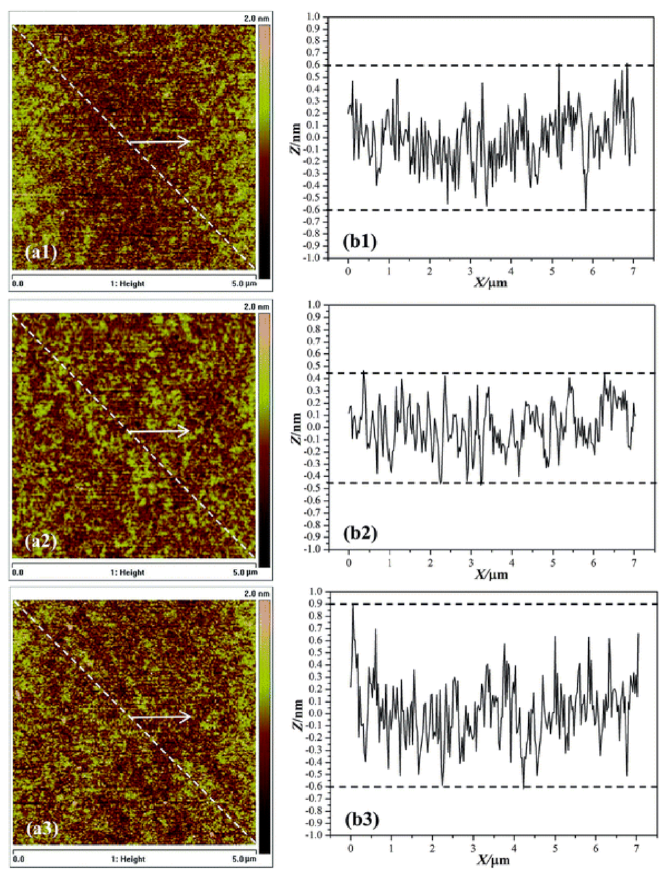
Figure 15. Two–dimensional AFM images and corresponding line scan profiles of the substrates after finishing with composites—A ( a1 , b1 ), —B ( a2 , b2 ), and —C ( a3 , b3 ), in which the line scan profiles in ( b1 ), ( b2 ), and ( b3 ) are obtained by scanning the dashed line positions in ( a1 ), ( a2 ) and ( a3 ), respectively. Reproduced from